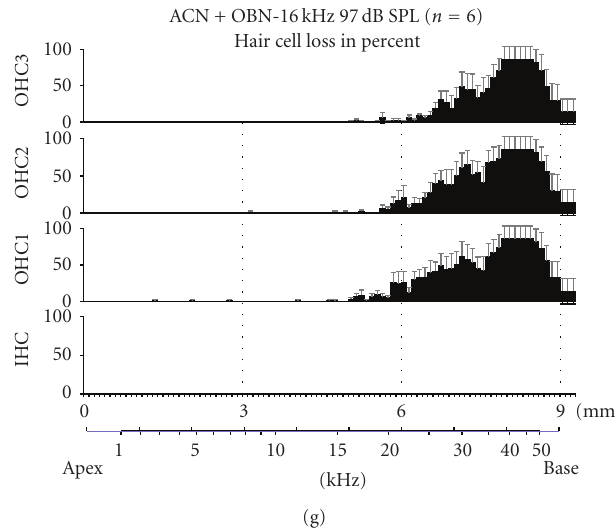
Figure 4: Average cochleograms showing hair cell loss in rats exposed to (a) ACN alone or to the 110 dB OBN-4 kHz with (c) or without (b) ACN, in rats exposed to the 97 dB OBN-8kHz with (e) or without (d) ACN, and in rats exposed to the 97dB OBN-16kHz with (g) or without (f) ACN. Abscissa (i) upper trace: length (mm) of the entire spiral course of the organ of Corti from the bottom of the hook, (ii) lower trace: frequency-map according to Muller [9]. Ordinate: hair cell loss in percent. IHC: inner hair cells; OHC1: first row of outer hair cells; OHC2: second row; OHC3: third row. Error bars represent the standard